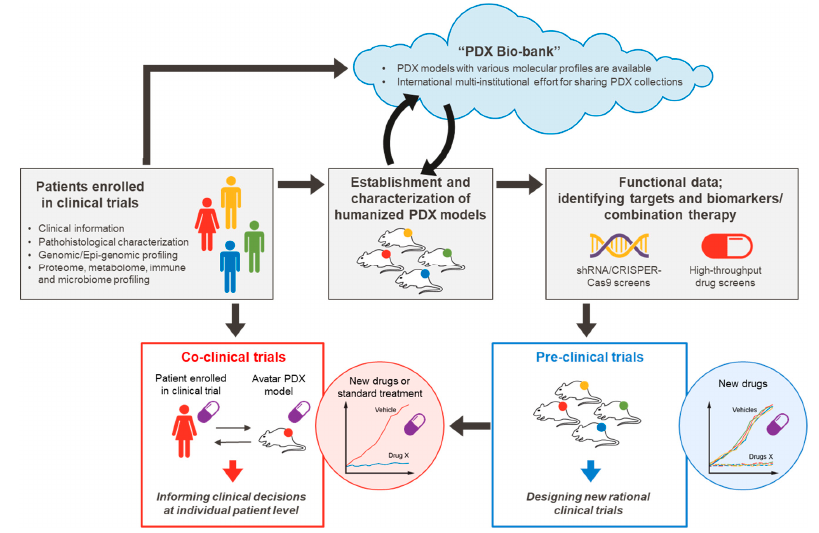
Figure 1. Precision medicine pipeline using patient-derived xenograft (PDX) models.